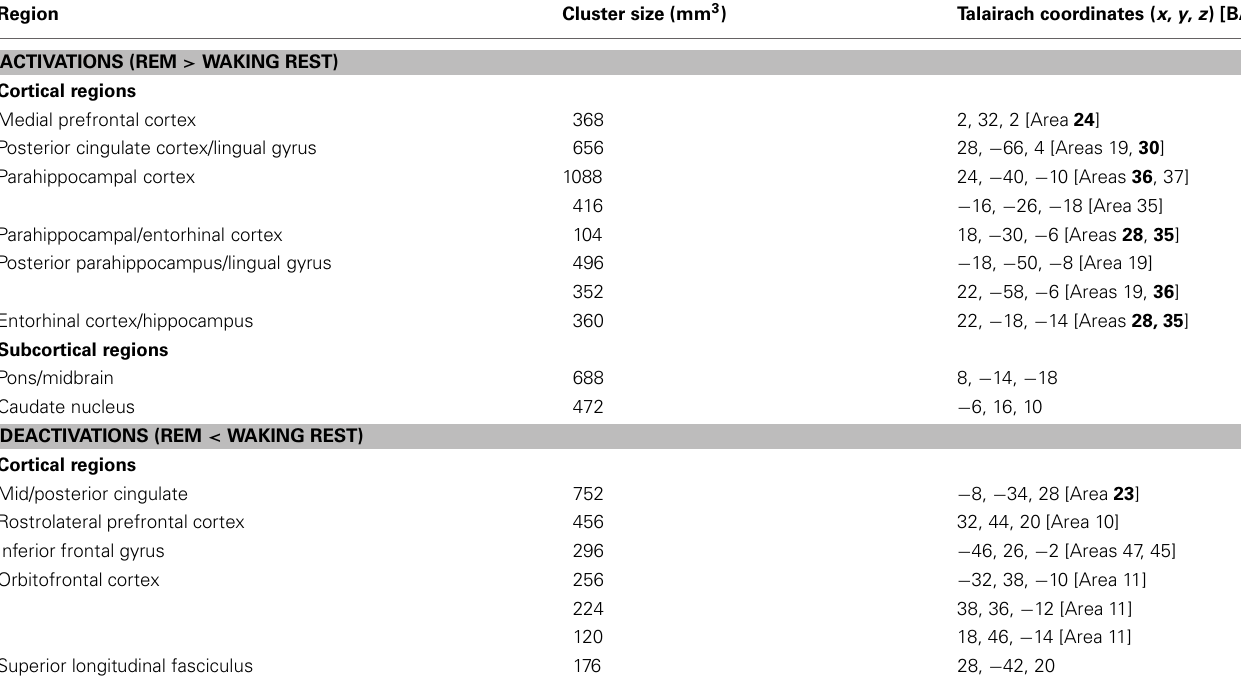
Table 2 | Core cortical components of the neural network underlying REM sleep.